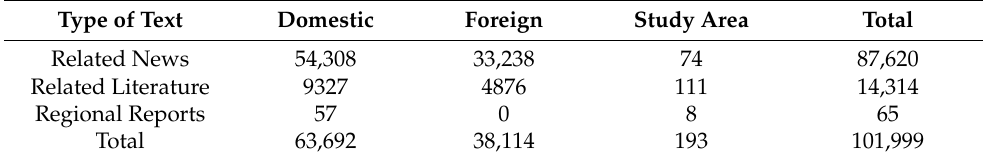
Table 2. Statistics of the corpus collection.